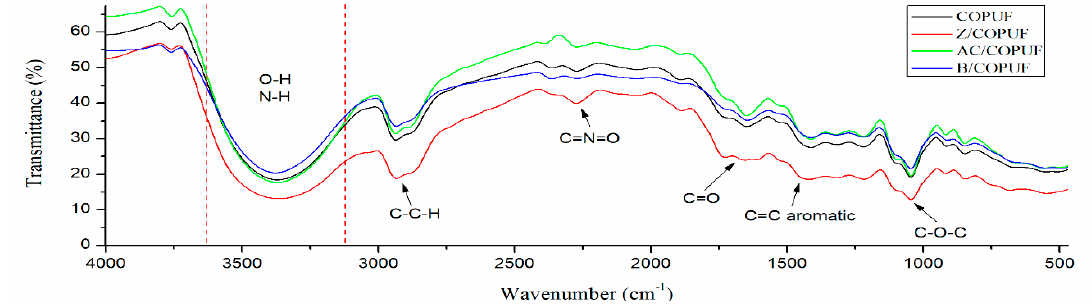
Figure 2. FTIR spectra of COPUF, Z/COPUF, AC/COPUF, and B/COPUF.